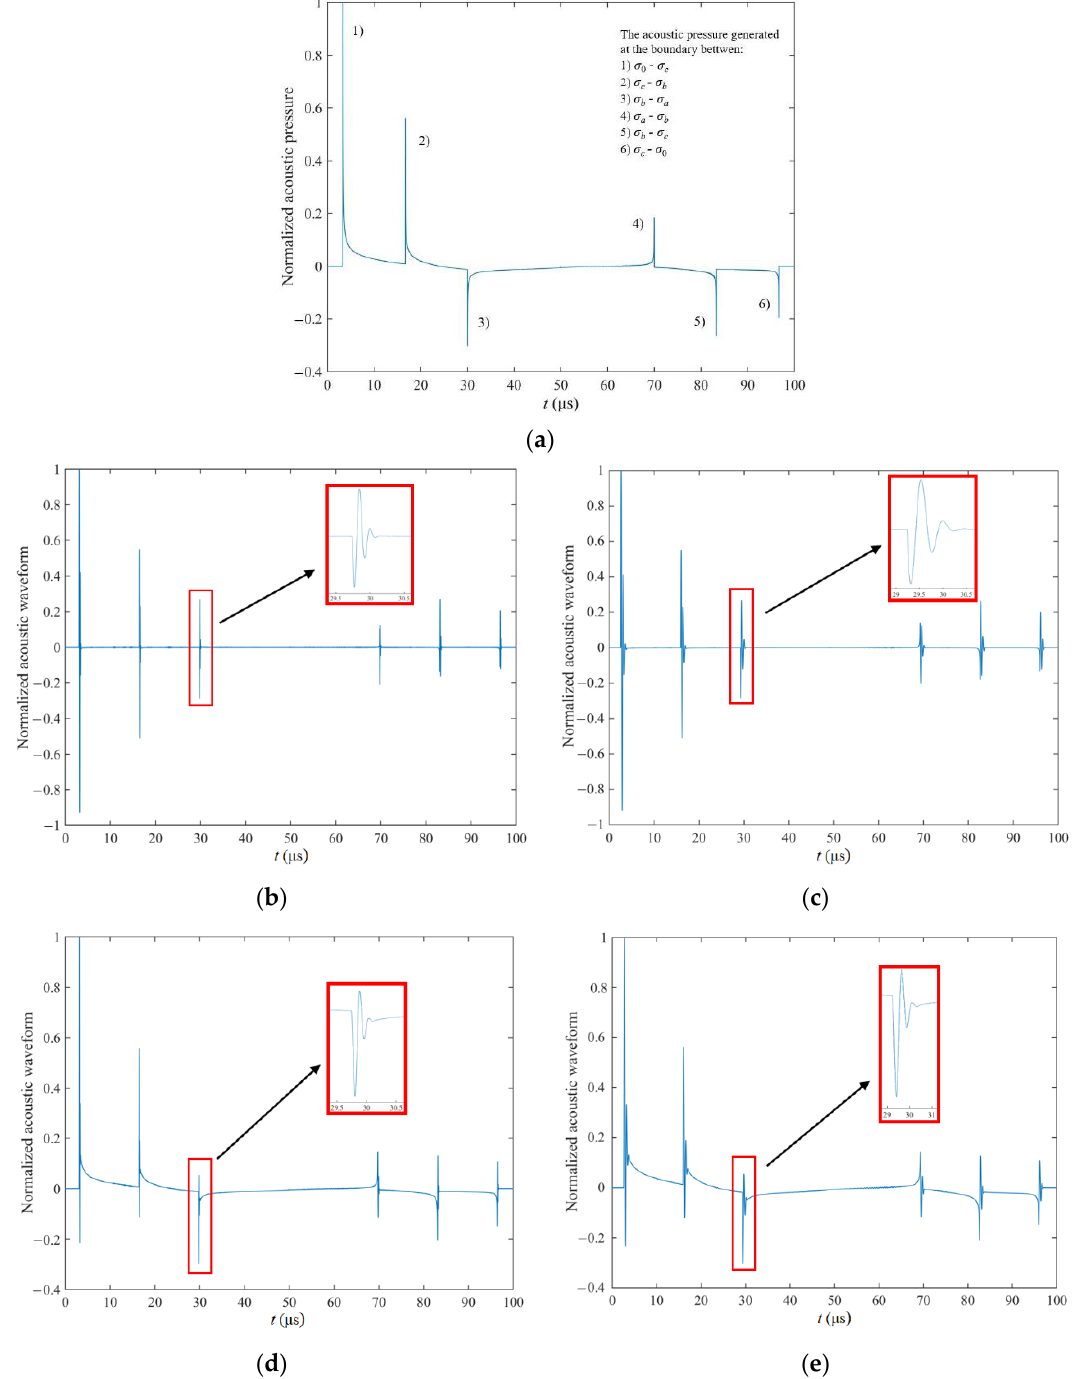
Figure 6. The analytical results for the infinitely long three-layer conducting circular cylinder: ( a ) acoustic pressure obtained at the angle of 0°; determined acoustic waveforms based on the system transfer function: the real-valued Morlet waveform in the case of ( b ) 1 MHz and ( c ) 0.32 MHz, and the imaginary-valued Morlet waveform in the case of ( d ) 1 MHz and ( e ) 0.32 MHz obtained at the angle of 0°.